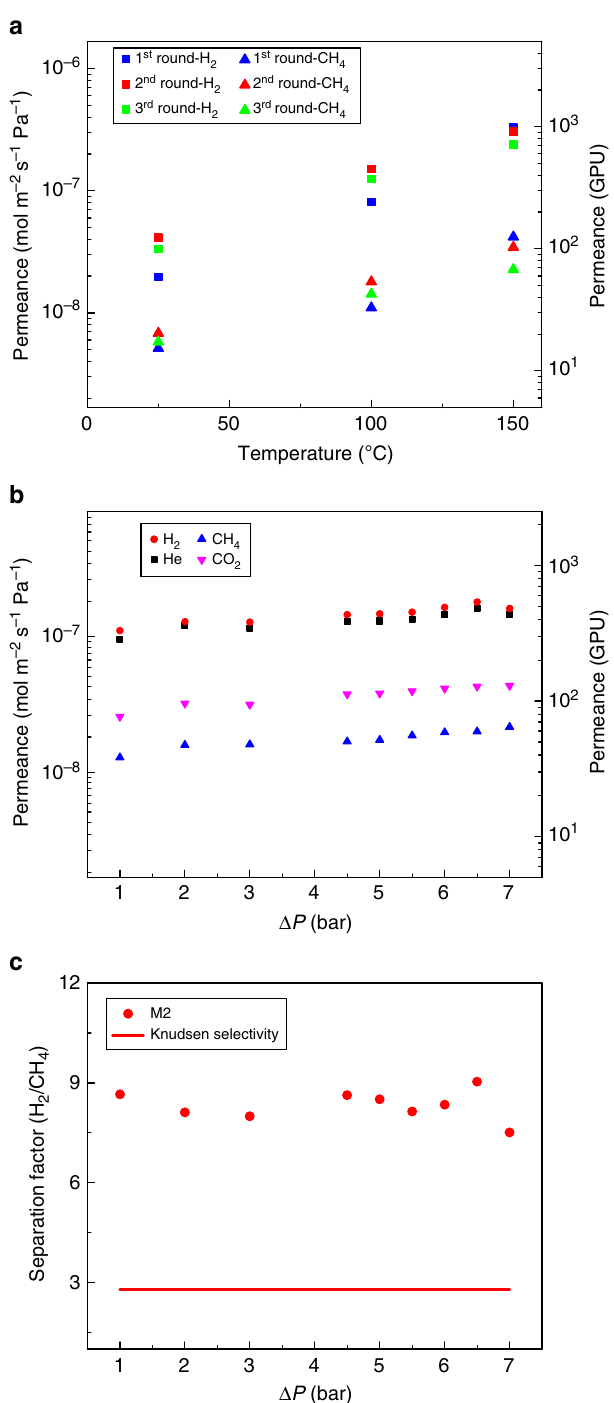
Fig. 5 Stability test of the graphene membrane. a H 2 and CH 4 permeances of the membrane M2 with three consecutive temperature cycles.